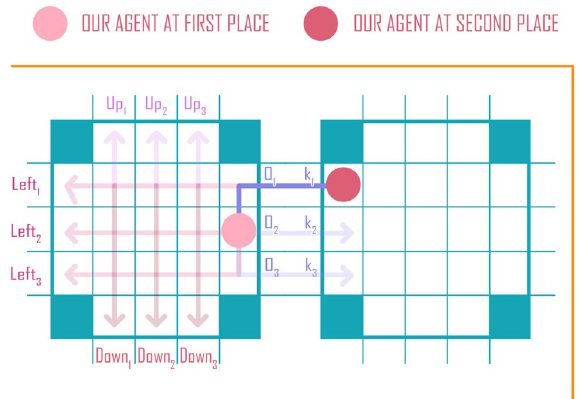
Figure 7. Possible actions of an agent in a PCN environment. At each location, the agent can take 12 possible actions. Depending on the action, the agent can remain on the same photonic chip or move to an adjacent one.